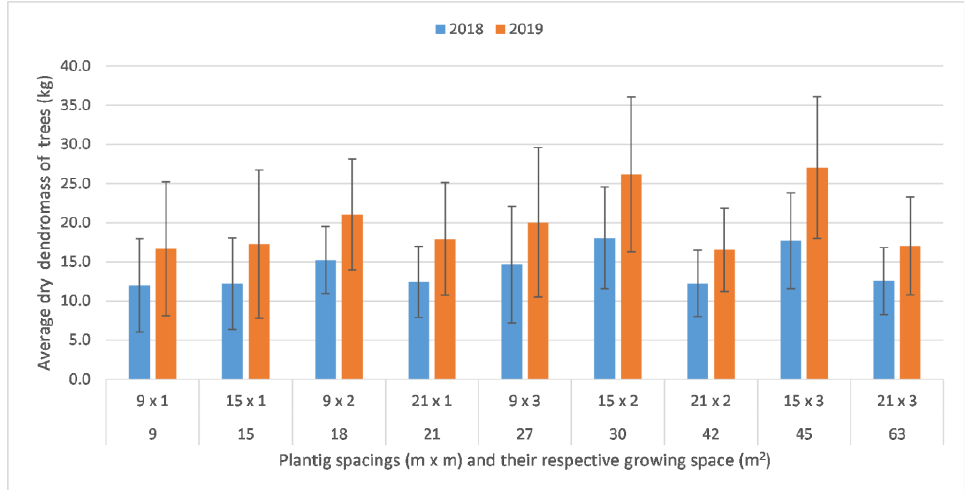
Figure 1. Average above-ground dry mass of black locust trees according to different tree spacings in agroforestry systems at the ages of 4 and 5. The growing spaces are indicated below the tree spacings. The error bars denote standard deviation ( α = 0.05; 2018: n = 272; 2019: n = 263). The total volume and total above-ground dry dendromass of stands per hectare at the ages of 4 and 5 are in Table 3.